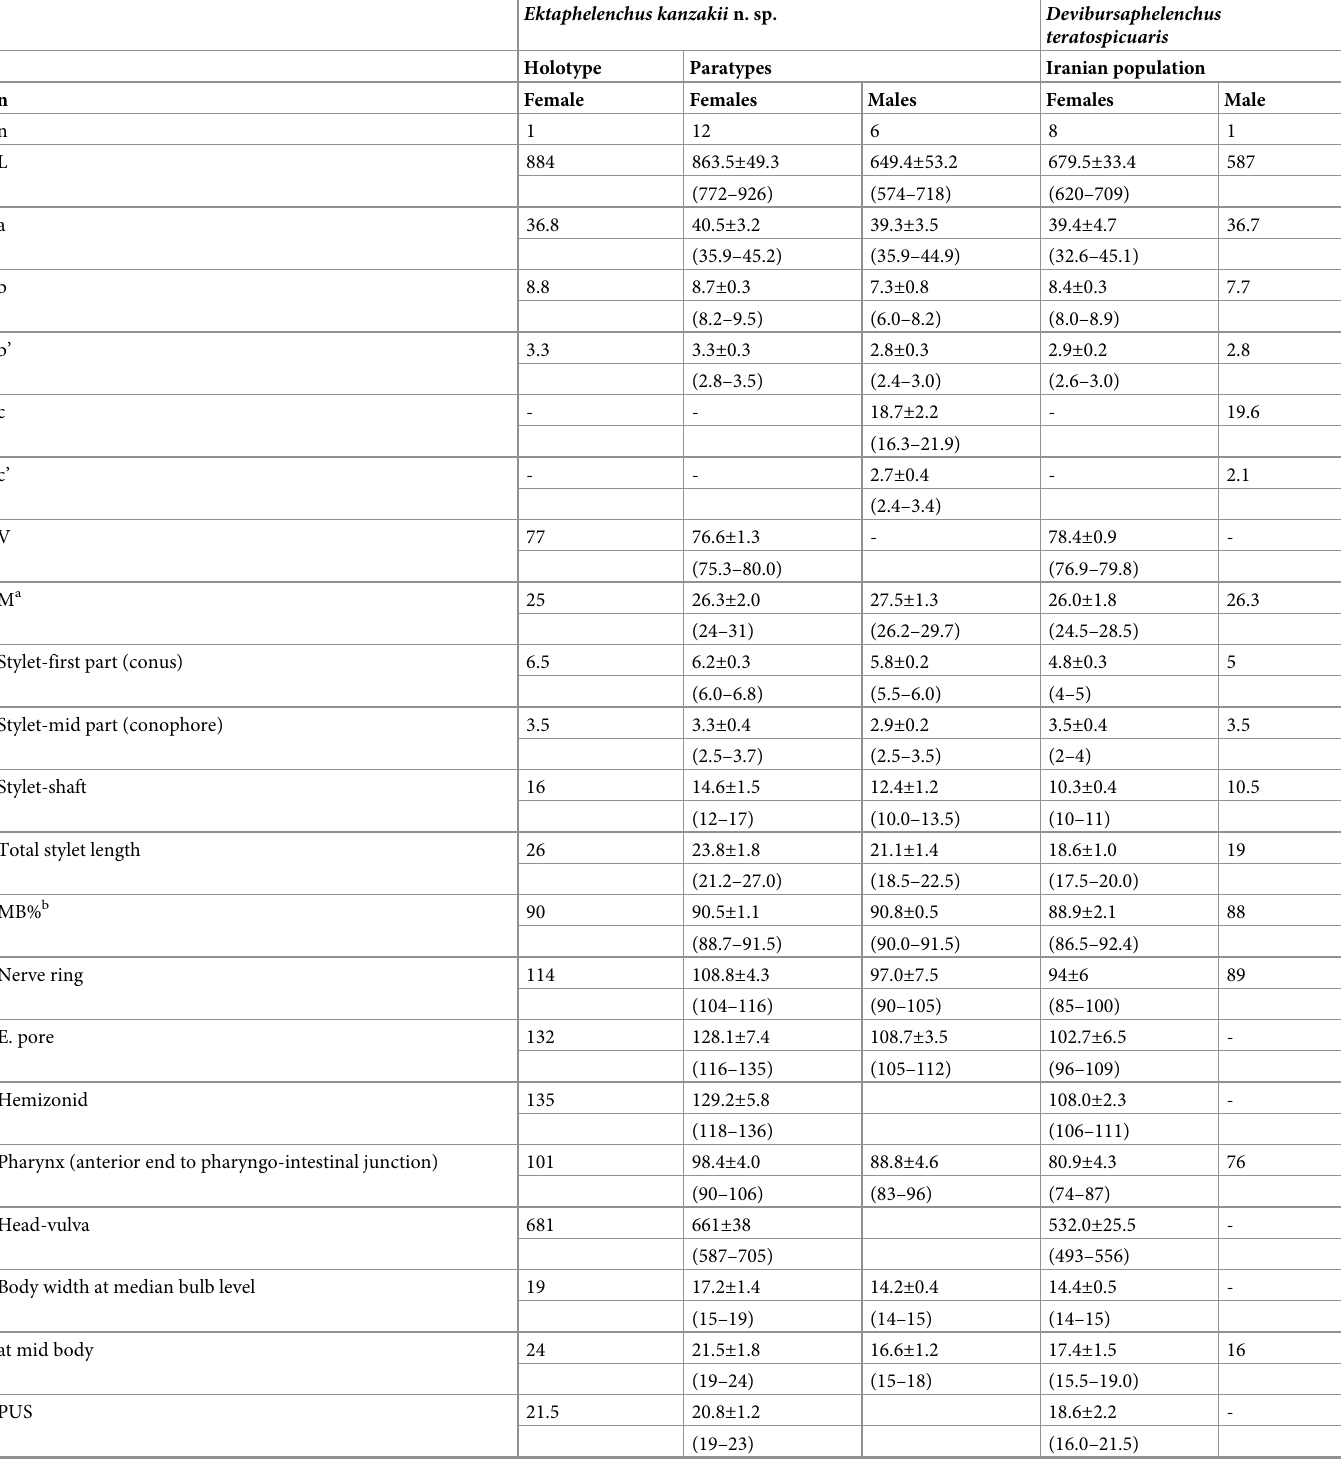
Table 1. Morphometrics of Ektaphelenchus kanzakii n. sp. and Iranian population of Devibursaphelenchus teratospicularis Kakulia & Devdariani, 1965. All mea- surements are in μ m and in the form mean ± S.D. (range). Ektaphelenchus kanzakii n.